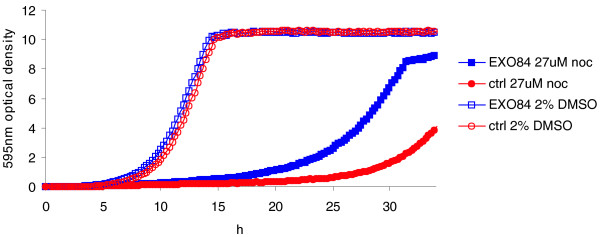
Overexpression of Exo84 alleviates the sensitivity of the control to 27 μM nocodazole. The optical density at 595 nm over time for wild-type BY4743 cells harboring the Exo84 overexpression construct compared to that of controls (ctrl) transformed with plasmid lacking a gene insert (for details, see Materials and methods, and for replicates, see Supplementary Figure 10 in Additional file 1).